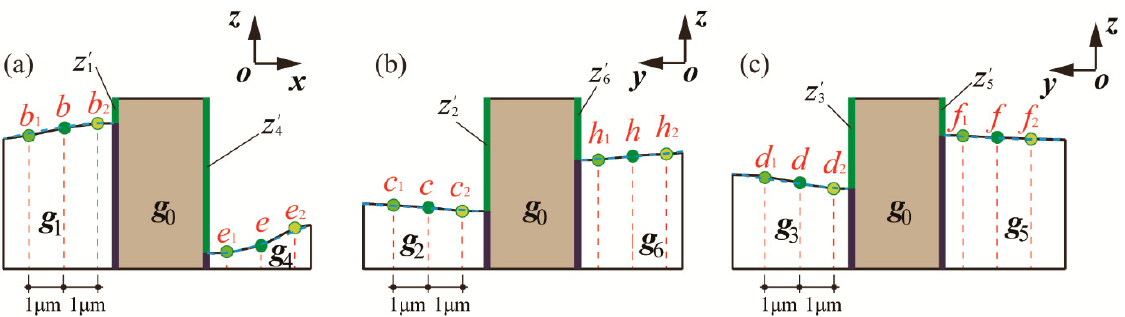
Figure 3. Z-directional relative heights of three positions on adjacent grains individually probed by nanorobot along plane X-Z and plane Y-Z profile at equal distances. ( a ) A projection drawing of Z-direction relative height differences of g 1 and g 4 relative to g 0 along the X direction. ( b ) Projection drawing of Z-direction relative height differences of g 2 and g 6 relative to g 0 along the Y direction. ( c ) Projection drawing of Z-direction relative height differences of g 3 and g 5 relative to g 0 along the Y direction.